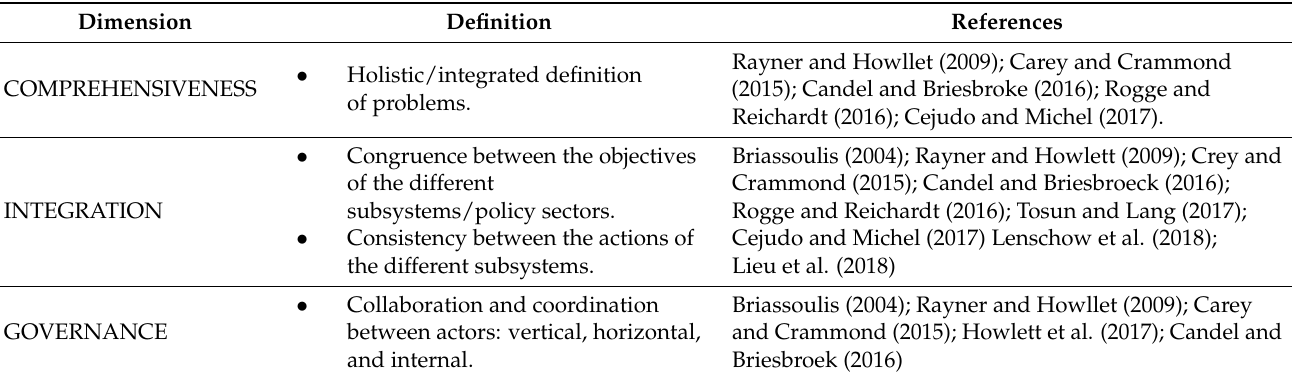
Table 1. Dimensions of integrality in the design of integrated